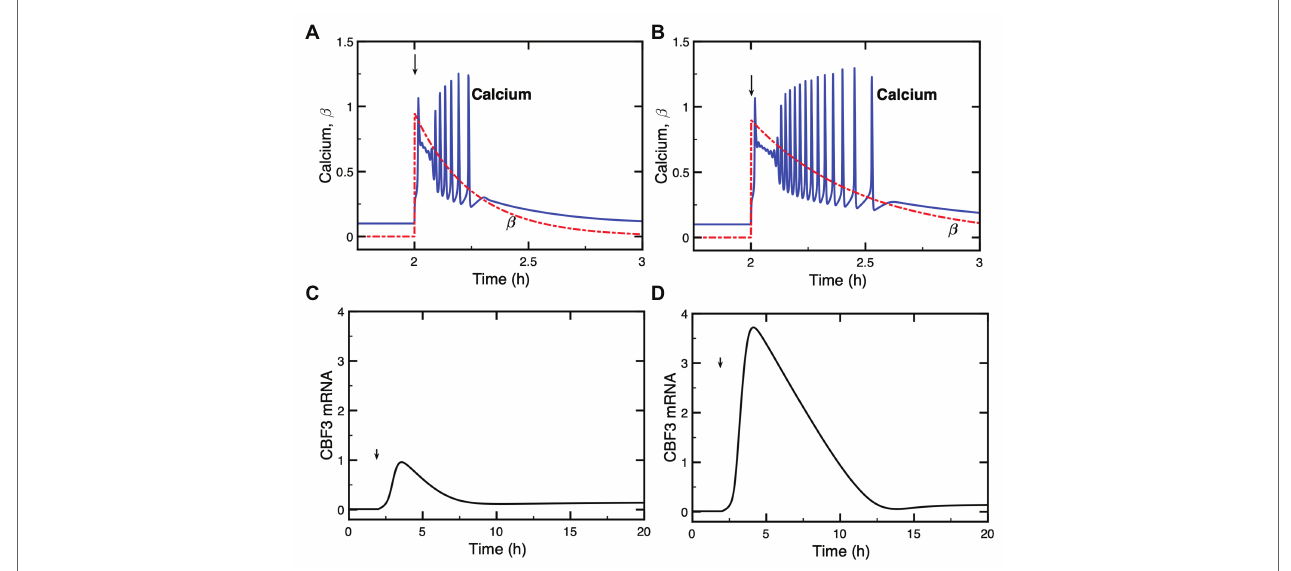
FIGURE 4 | Dynamics of the model for the cold response pathway when the cold stress elicits a train of high-frequency Ca 2+ oscillations. Panels (A,B) : the single cold shock elicits a train of Ca 2+ pulses, which contains a few (A) or a larger number (B) of Ca 2+ spikes. Panels (C,D) show the evolution of CBF3 mRNA corresponding to panels (A,B) , respectively. After an initial increase at time t p = 2 h, parameter β decays exponentially according to the equation